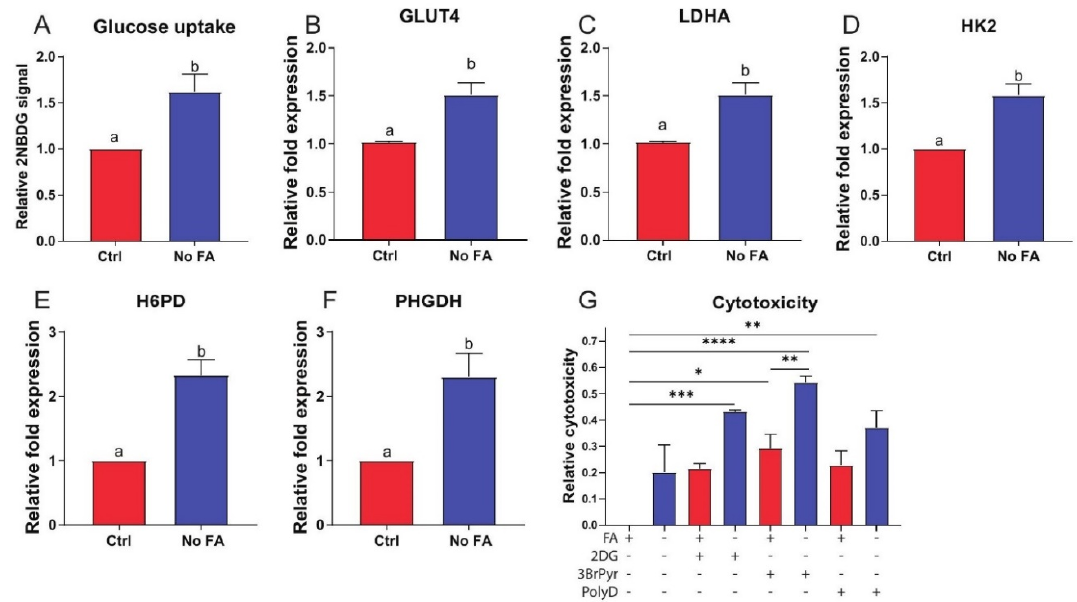
Figure 4. Effect of FA on glucose metabolism in cultured MDA-MB-231 cells. MDA-MB-231 cells cultured in standard (2.2 µ M) or FA-deficient (0 µ M) medium for 3 weeks prior to analysis. Glucose uptake determined by 2NBDG staining (n = 3/group) ( A ). Expression of GLUT4 ( B ), LDHA ( C ), HK2 ( D ), H6PD ( E ), and PHGDH ( F ) determined by qPCR (n = 3/group). Cytotoxicity following withdrawal of FA in the presence of 50 mM 2-deoxyglucose (2DG), 30 µ M 3- bromopryuvate (3BrPyr), or 10 µ M polydatin (PolyD) for 48 h as determined by MTT assay (n = 4/group) ( G ). Student’s t -test ( A – F ) or one-way ANOVA ( G ) used to determine statistical significance ( p < 0.05) between groups. Different letters indicate significant differences determined by Student’s t -test. Asterix’s indicate significant differences determined by one-way ANOVA (* p < 0.05, ** p < 0.01, *** p < 0.001, **** p <